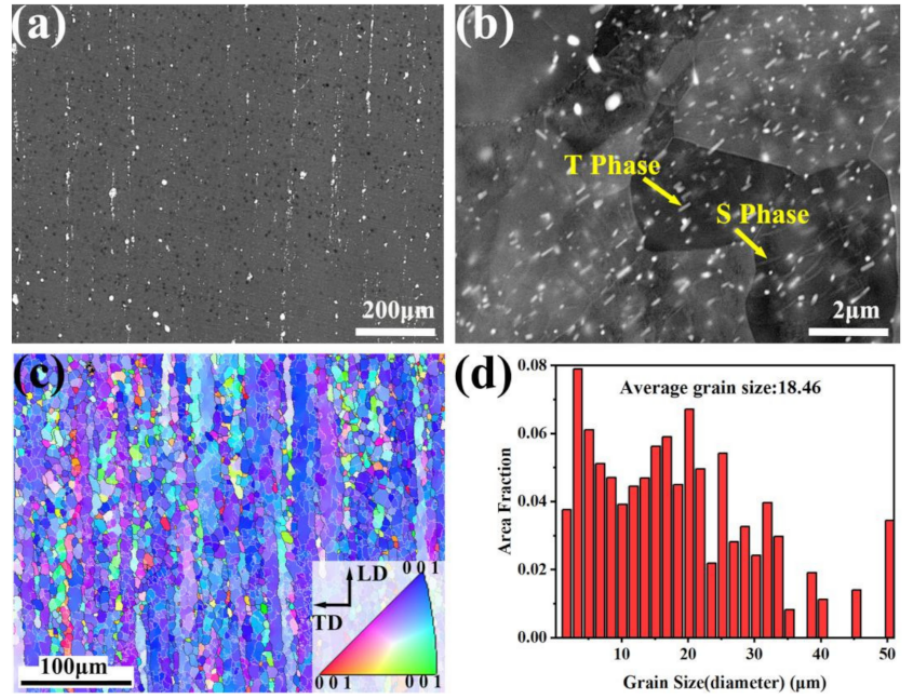
Figure 9. Heat treatment microstructure of UE + ACAE-forming cabin Zone V: ( a ) BSE Figure 1; ( b ) BSE Figure 2; ( c ) IPF figure; ( d ) grain size